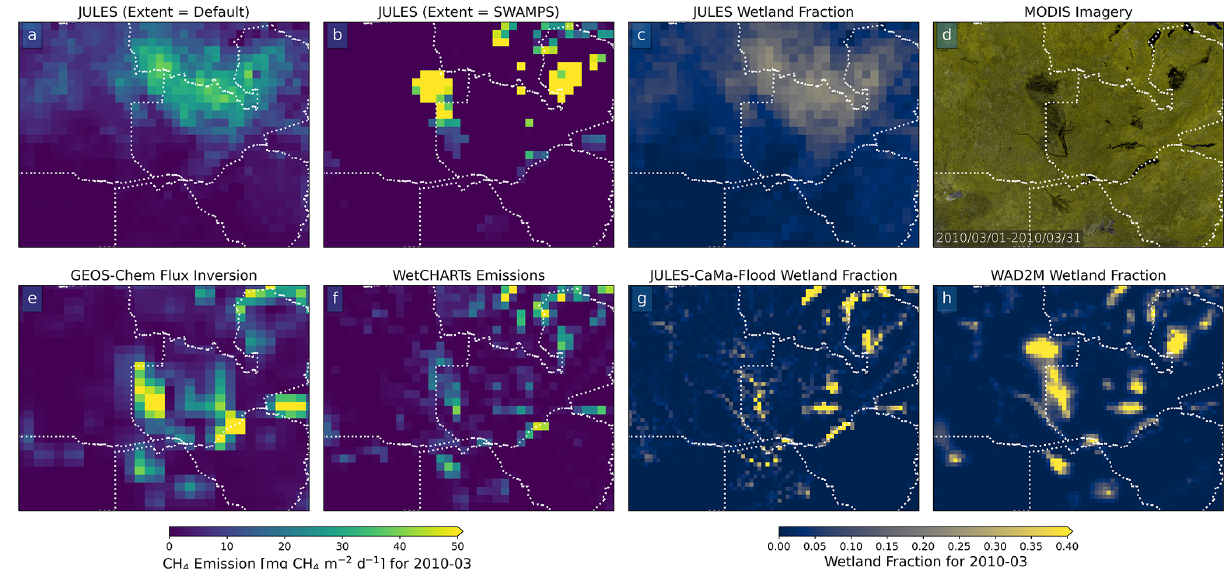
Figure 13. Comparison over the Southern Africa wetland region showing the wetland CH 4 emissions for March 2010 for (a) JULES with the default wetland extent, (b) JULES with the SWAMPS masking for wetland extent, (e) GEOS-Chem flux inversion of GOSAT XCH 4 over Africa and (f) the WetCHARTs ensemble mean. Also shown are the wetland fractions from (c) JULES, (g) JULES-CaMa-Flood and (h) WAD2M along with (d) MODIS (RGB) surface reflectance. Both JULES simulations are the configurations that use the WFDEI meteorological driving, the lower Q 10 value and phenological vegetation, as these were shown to provide the best result over this region (see Fig.